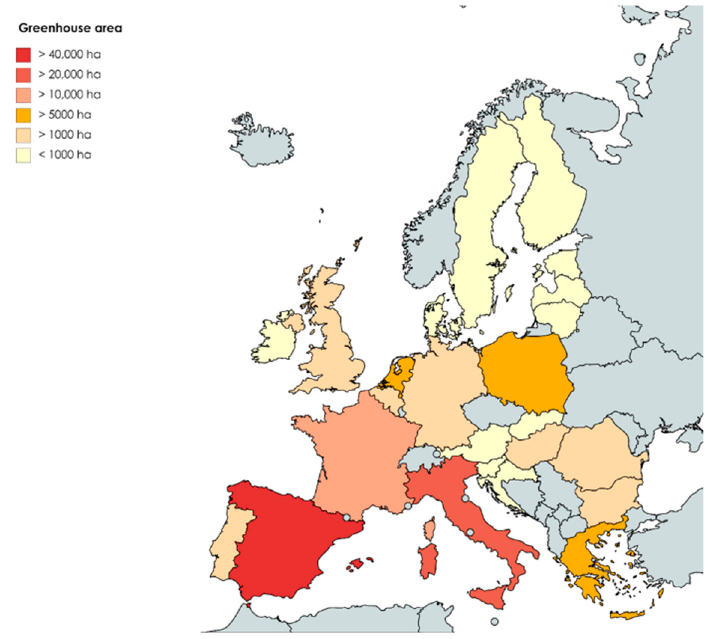
Figure 1. Greenhouse area for vegetables, flowers, ornamental plants and permanents crops in Europe— 2016 dataset [1].